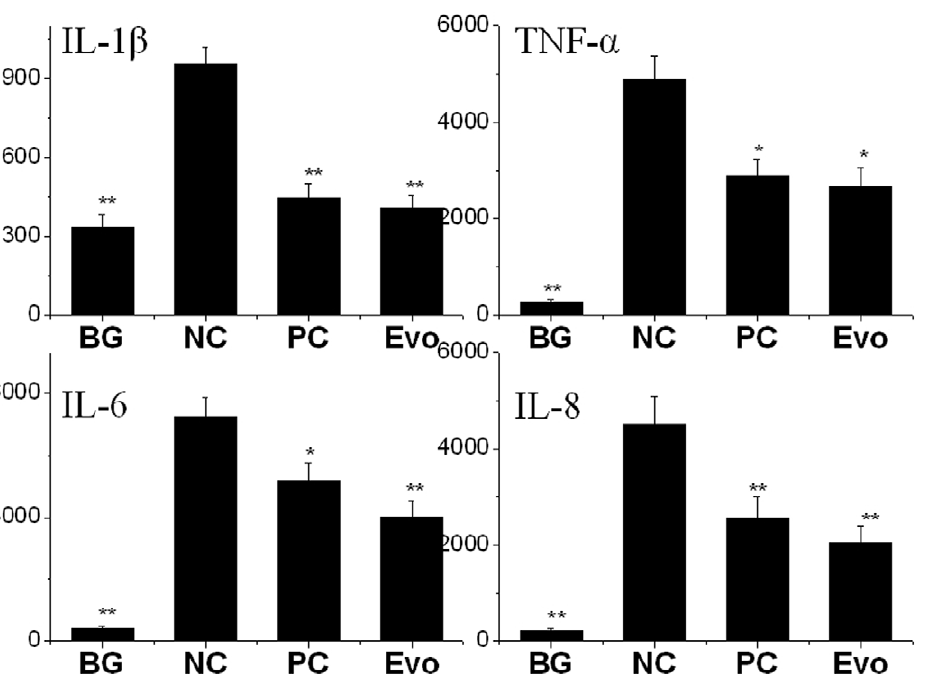
Figure 9. The influence of evodiamine on the cytokine release determined by ELISA (pg/mL). Cell culture supernatants were collected and frozen at 2 80 u C. The treatments were same with that mentioned in Fig. 7. Data shown were the mean 6 SD of three independent experiments. * P , 0.05, ** P , 0.01, vs . the NC.